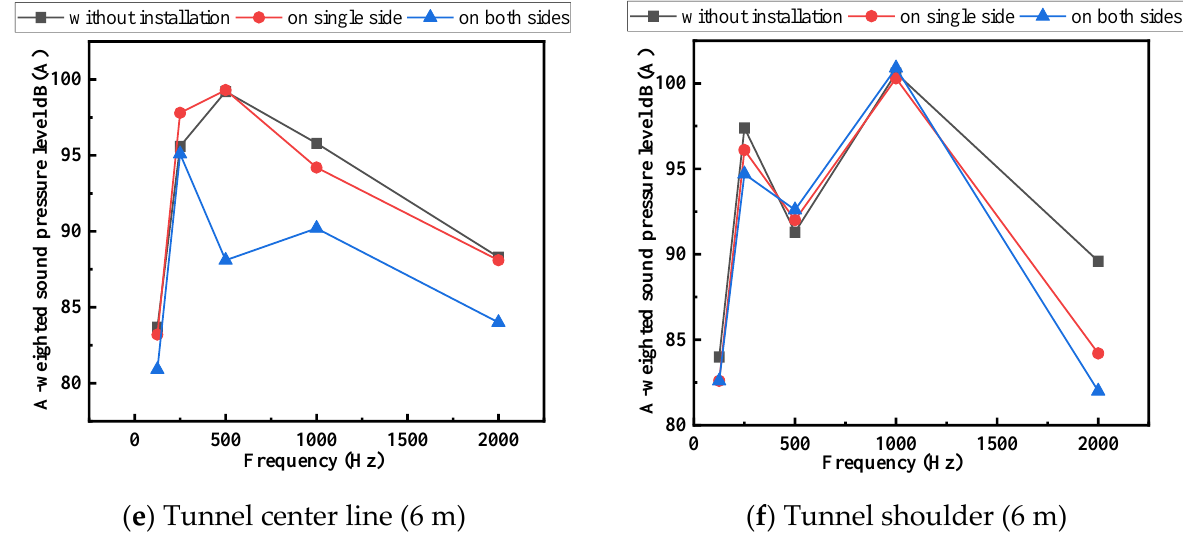
Figure 10. Influence of frequency.